Question: Provide a one-line summary of what is displayed.
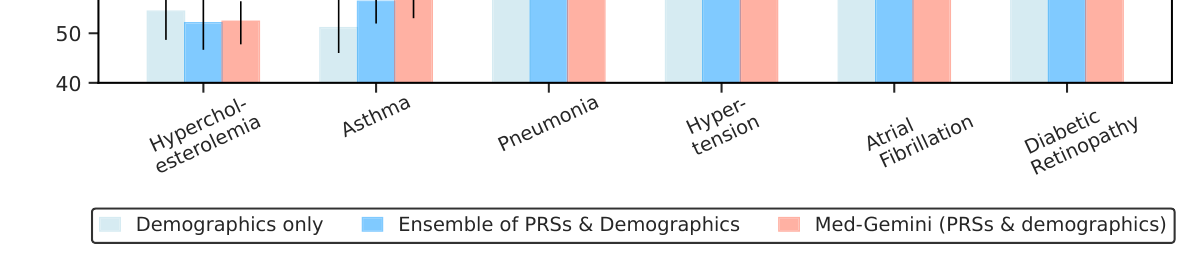
Answer: | Health outcome prediction using Med-Gemini-Polygenic compared to two baselines for both in- distribution and out-of-distribution outcomes. “Demographics only” used a linear probe of age, sex, and BMI to predict each health outcome, and “Ensemble of PRSs and demographics” combined demographics with all 7,145 PRSs in a linear probe. Med-Gemini-Polygenic was prompted with both an individual’s PRS image and demographics. For out-of-distribution health outcomes, the linear probes (“Ensemble of PRSs and demographics” and “Demographics only”) were trained to predict the most-correlated in-distribution outcome (Table A.11), and those predictions were then evaluated on the out-of-distribution outcome.